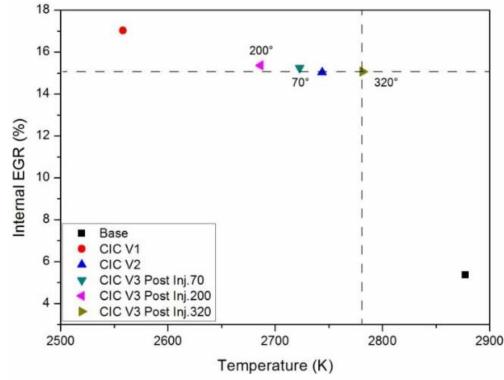
Figure 18. Comparison of internal EGR rate for different variable valve control